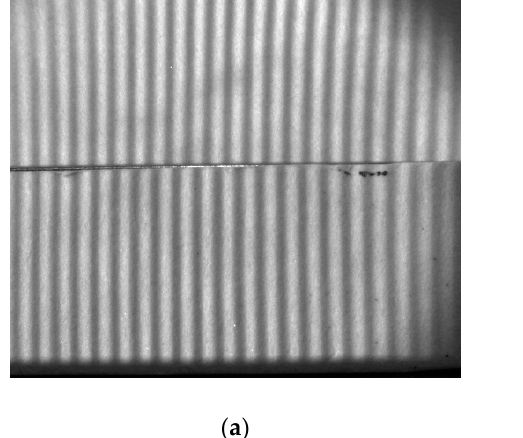
Table 3. Summary of involute, lead, and topology deviations compared with the CMM results.